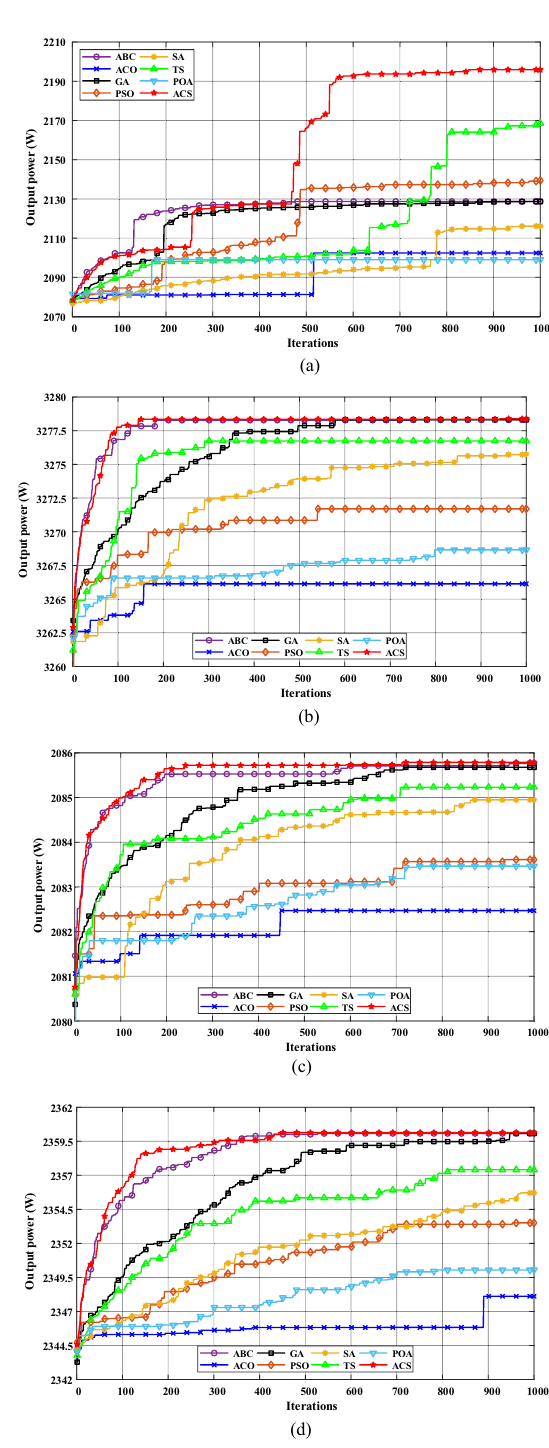
Fig. 13 Convergence curves of eight algorithms under four different scenarios of a (20 15) TEG system: a diagonal, b outer, c inner, and × d